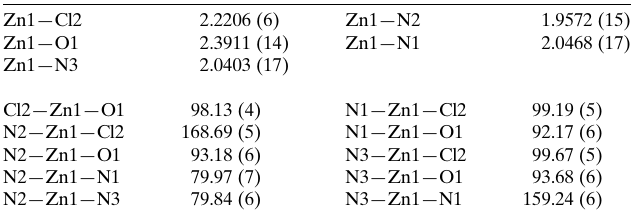
Table 1 Selected geometric parameters (A˚ , (cid:4) ).